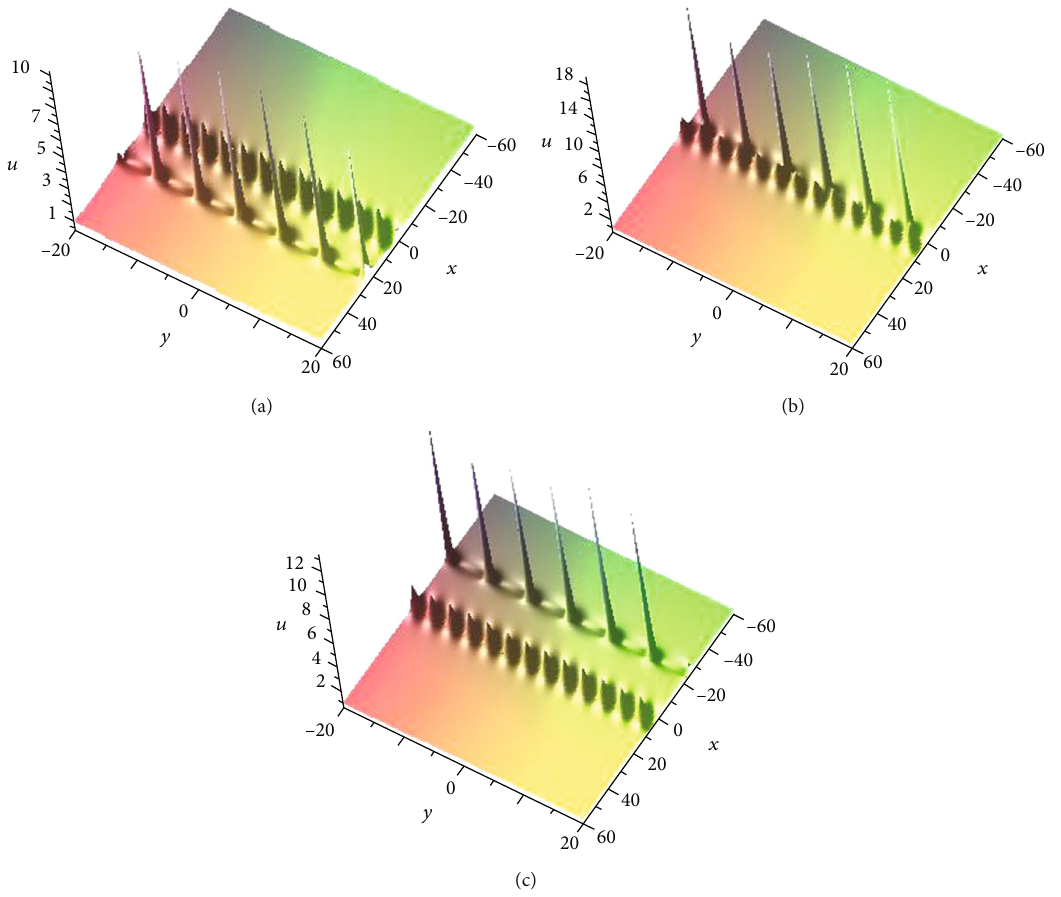
= − 15 , β 0 = − 15 , β 0 = 0 , and β 0 = 0 . (b) Breather-breather molecule in β 0 1 2 3 4